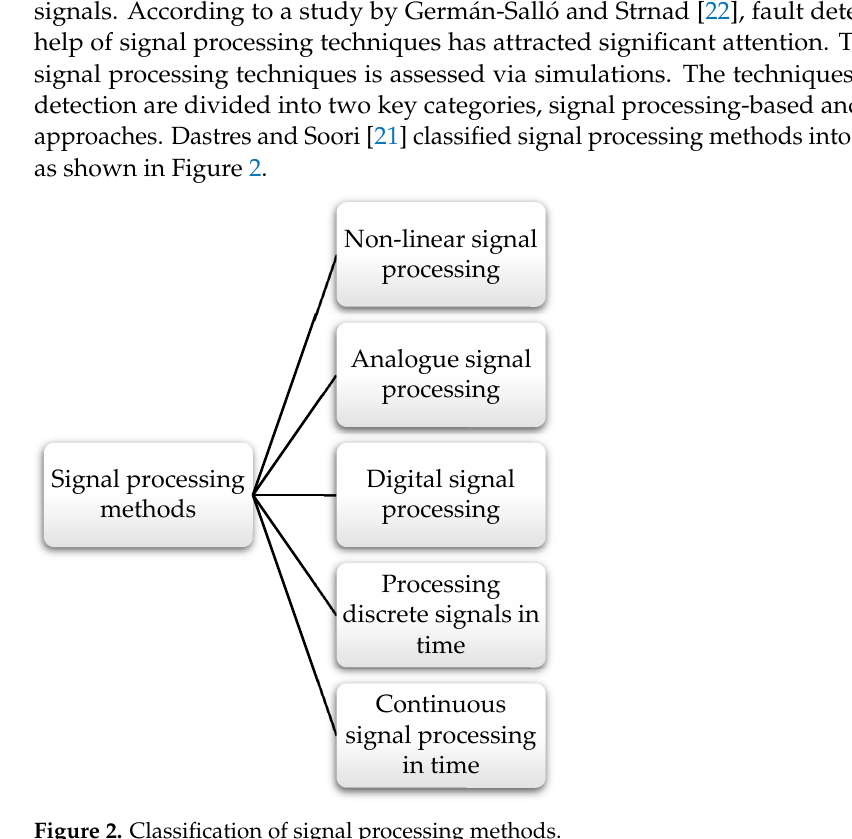
Figure 2. Classification of signal processing methods.